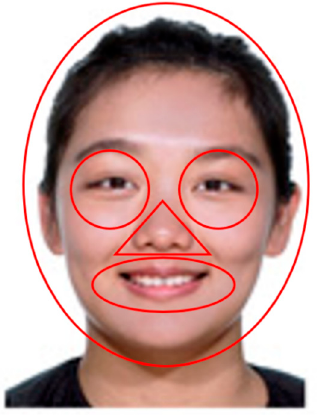
Figure 2. Illustration of areas of interest (AOIs) corresponding to the left eye (width: 104 pixels, 2.651 ◦ ; height: 104 pixels, 2.651 ◦ ), right eye (width: 104 pixels, 2.651 ◦ ; height: 104 pixels, 2.651 ◦ ), nose (width: 91 pixels, 2.320 ◦ ; height: 55 pixels, 1.402 ◦ ), mouth (width: 176 pixels, 4.485 ◦ ; height: 87 pixels, 2.218 ◦ ), and the whole-head (width: 399 pixels, 10.147 ◦ ; height: 479 pixels, 12.167 ◦ ). We are authorized to use and publish the photographs of the person in the